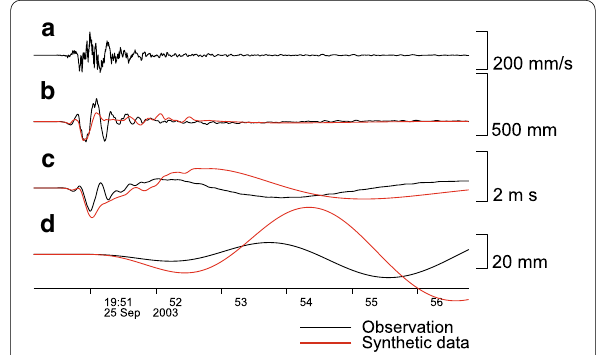
Fig. 2 Example seismic waveforms. a Original seismogram of the 2003 Tokachi-oki earthquake recorded at Urahoro station with a velocity-type strong-motion seismometer. b Displacement record (black curve) obtained after instrumental correction and integration of the original record shown in a . c Integrated displacement record (black curve) obtained from the original record shown in a . (d) Bandpass (200–400 s) filtered displacement record (black curve) obtained from the original record shown in a . The red curves in b – d show synthetic records for the finite fault model of U. S. Geological Survey (2020)